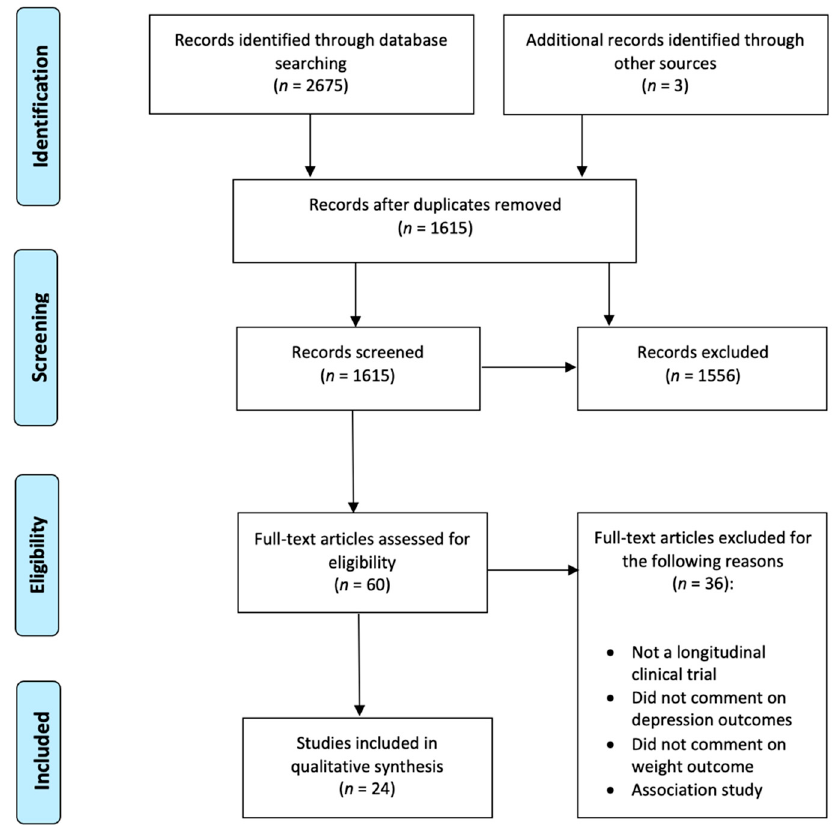
Figure 1. PRISMA flow diagram.